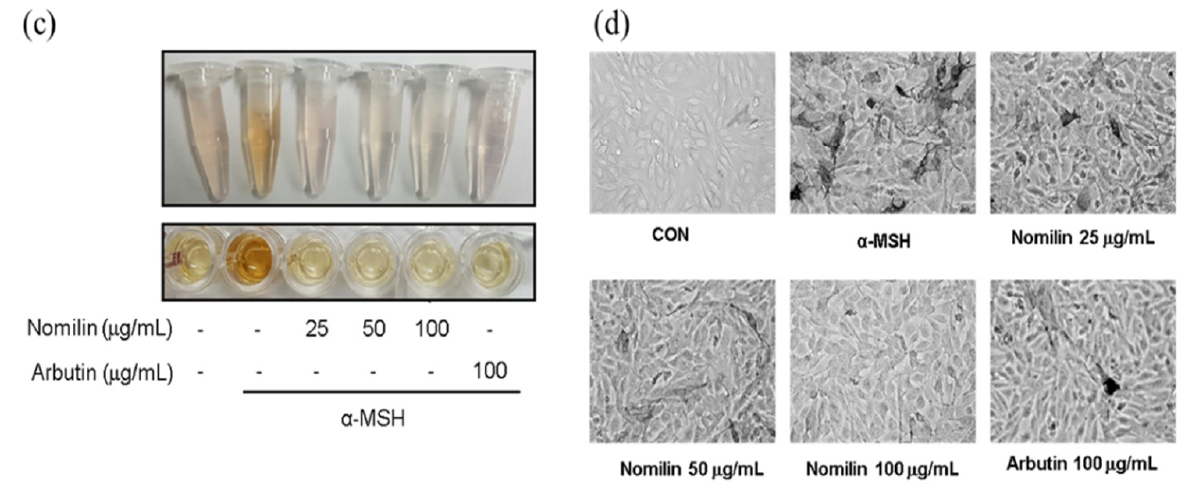
Figure 7. Measurement of melanin content in B16F10 melanoma cells treated with nomilin and limonin. ( a ) Measurement of melanin content with 25–100 µg/mL nomilin (48.59–194.34 µM). ( b ) Measurement of melanin content with 25–100 µg/mL limonin (53.13–212.53 µM). Relative melanin content was determined at 72 h after treatment. n = 3, error bars, mean ± standard deviation. Effect of 100 µg/mL arbutin (367 µM) on melanin synthesis and tyrosinase activity in B16F10 cells. ( c ) B16F10 melanoma cells. ( d ) Morphological changes due to nomilin. B16F10 cells were cultured for 48 h in the presence of 25–100 µg/mL (48.59–194.34 µM) nomilin and 100 µg/mL (367 µM) arbutin as a positive control or 1 µg/mL α -MSH. Significantly different compared with α -MSH, * p < 0.05, **